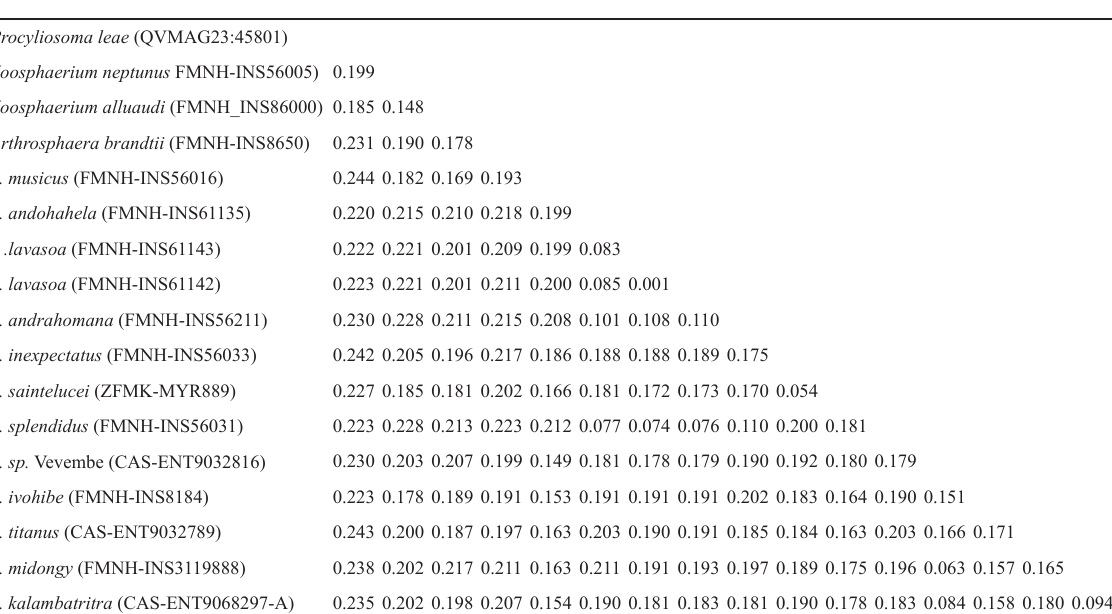
Table 2. Genetic p-distances between species of Sphaeromimus de Saussure & Zehntner, 1902. Variation among sites was modeled with gamma distribution with shape parameter = 1. Included were codon positions 1 st +2 nd +3 rd